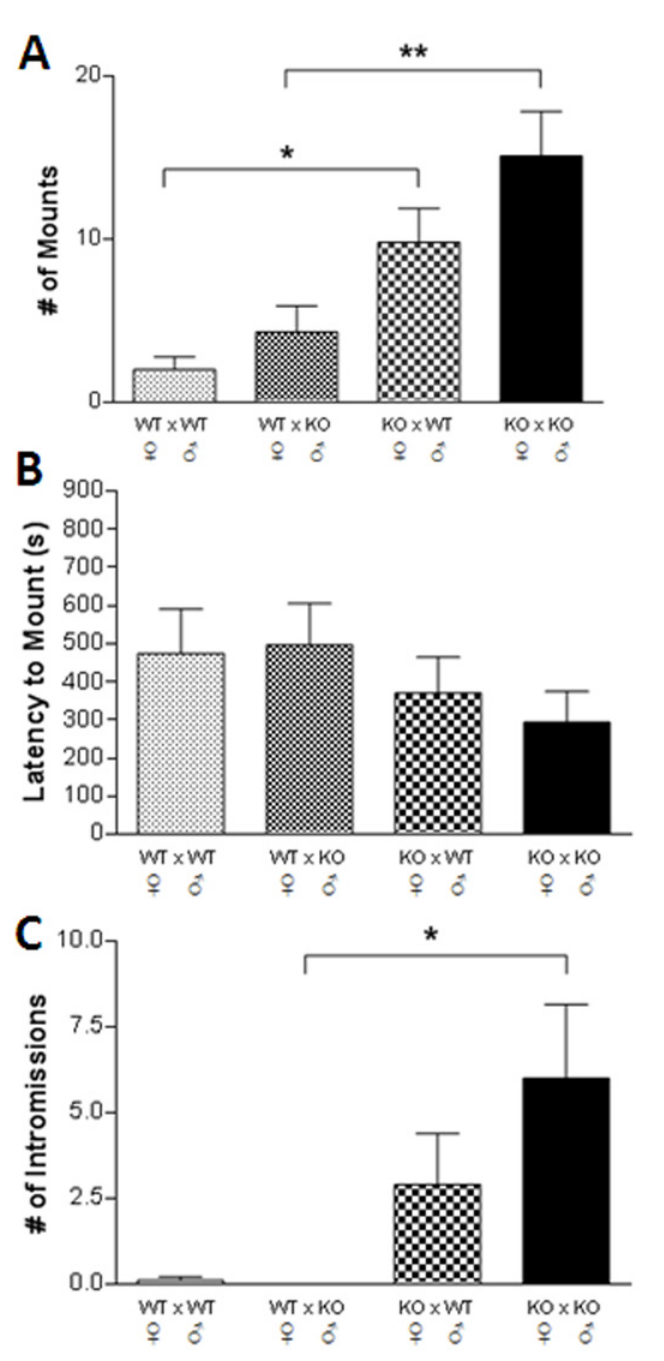
Fig 2. Male sexual preference in one-on-one encounters. (A) # of mounts when a single WT or KO male was exposed to a single, receptive WT or KO female, (B) latency to mount by WT and KO males when exposed to a receptive WT or KO female, (C) # of intromissions by WT and KO males when exposed to a receptive WT or KO female. Data are expressed as the mean ± SEM for groups containing 10 WT and 10 KO males. Symbols indicate significant difference from the indicated comparison. * p < 0.05; ** p < 0.01.